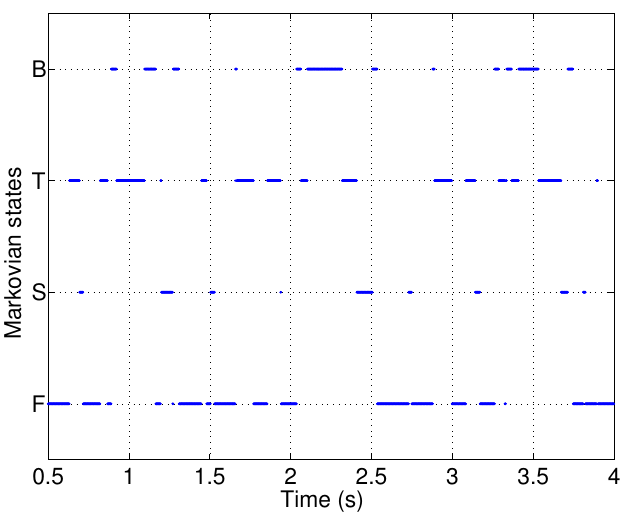
Figure 4. Markovian chain.